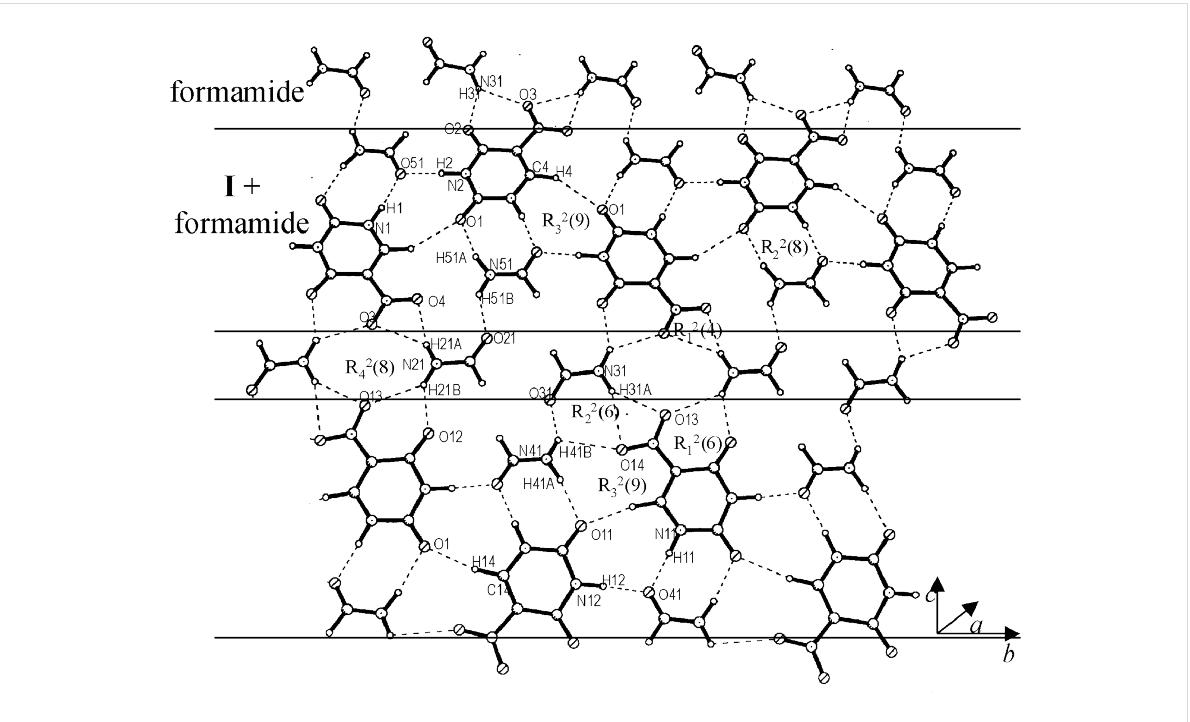
Figure 5: Cocrystal of I and formamide: A molecular layer showing tapes of mixed composition, I and formamide, alternating with formamide chains.